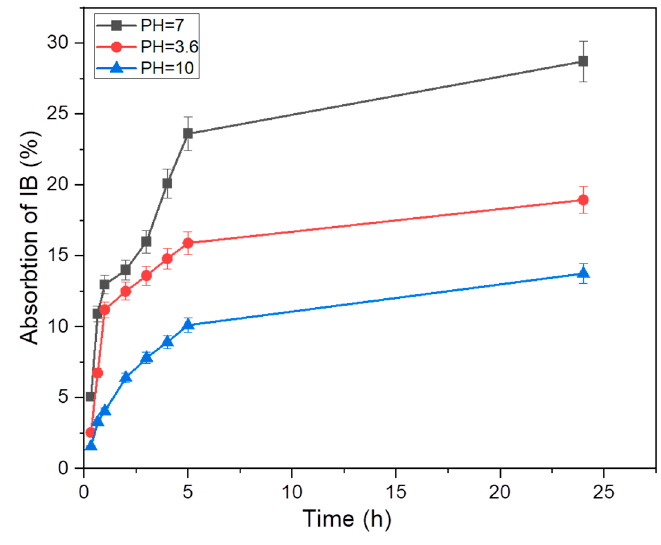
Figure 7. Optimization of pH for the absorption of IB.